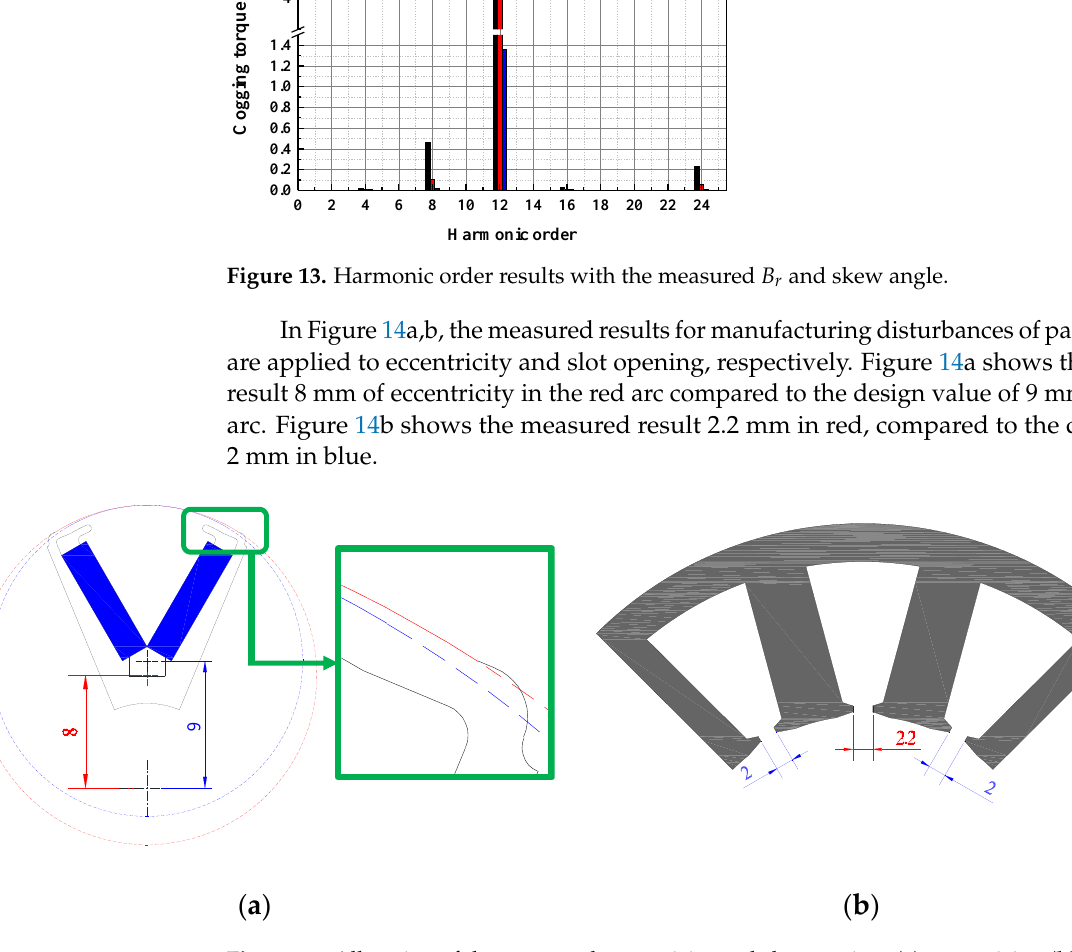
Figure 13. Harmonic order results with the measured B r and skew angle.